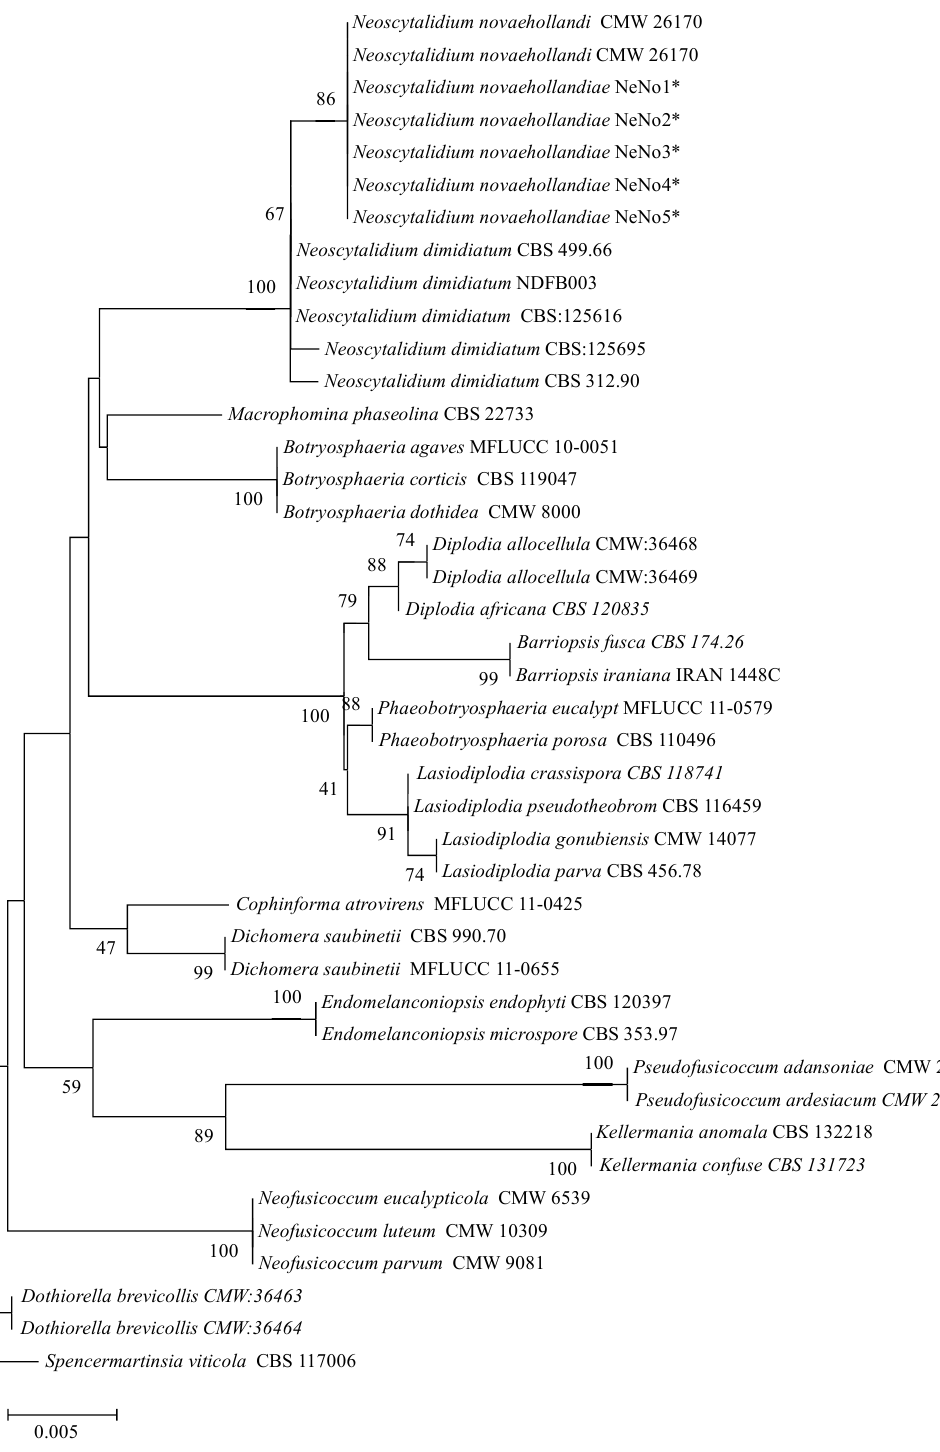
Figure 4. Maximum likelihood phylogram generated in Mega 5 from the alignment of 42 combined internal transcribed spacer (ITS), trans- lation elongation factor 1-alpha (EF1) and nuclear large subunit (LSU) gene portion dataset using Tamura 3-parameter model with com- plete deletion gap handling and 1000-replication bootstrapping. The values above the line denote bootstrap support for the node. Isolates of Neoscytalidium novaehollandiae reside in a highly supported terminal clade separate from isolates of N. dimidiatum. The isolates from Iran are marked with an